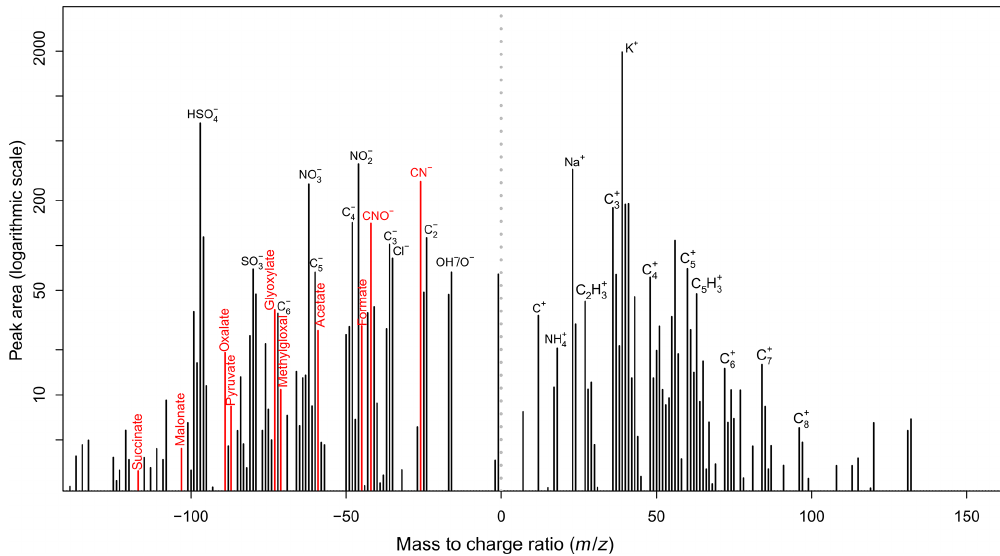
Figure 1. Representative mass spectrum for NOC-containing particles. The ion peaks corresponding to NOCs and oxidized organics are highlighted using red